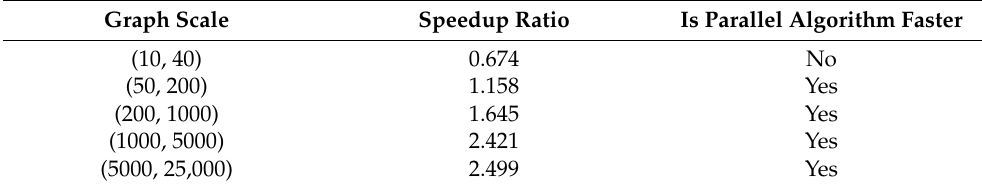
Table 5. Speedup effects of different scales of a graph. Graph